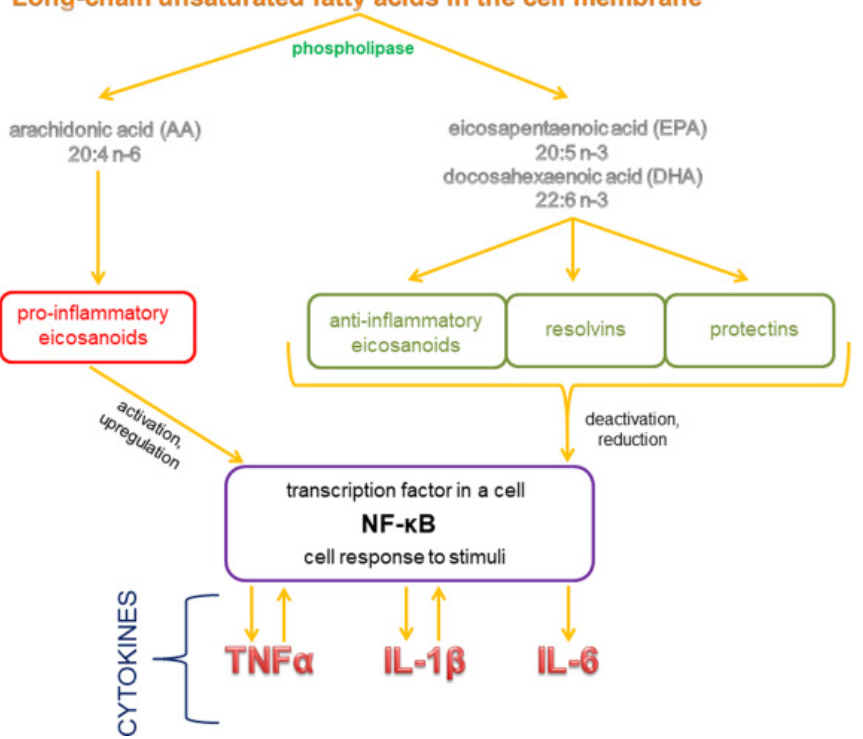
Figure 7. The mechanism by which fatty acids influence cytokine synthesis. Cytokines act on individual cells by binding to specific receptors on their surface. Cytokine receptors are classified into: class I cytokine receptors, class II cytokine receptors, TNF receptors, IL-1 receptors, tyrosine kinase receptors, and chemokine receptors [36]. Cytokines are associated mainly with pro-inflammatory responses, but they do not exert harmful effects on the host organism only. Cytokine activity and cytotoxic and cytostatic effects are determined by cytokine concentrations and the differentiation of target cells. At high concentrations, selected cytokines can inhibit the proliferation of human tumor cell lines, but when their concentrations are low, the same cytokines can